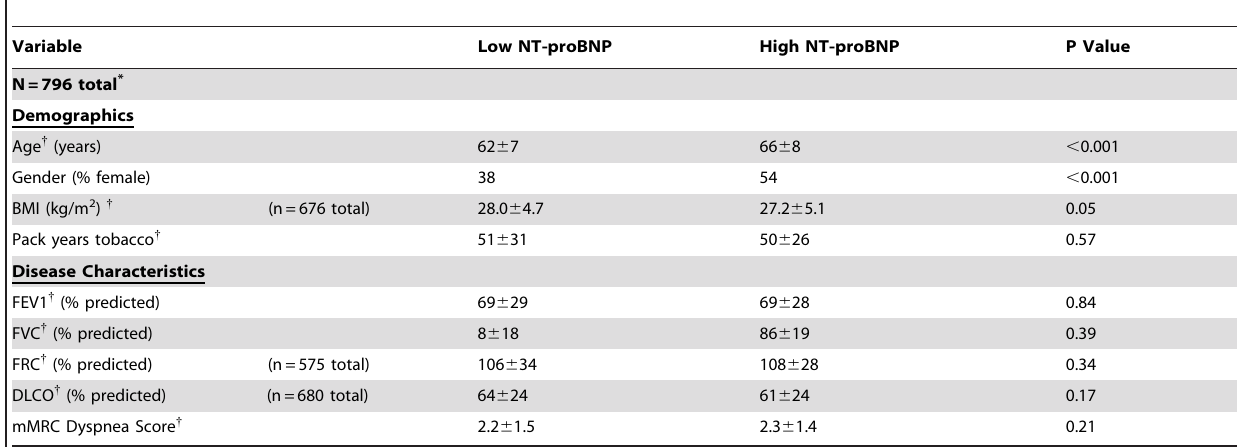
Table 2. Predictors of Elevated N-terminal pro-BNP ( $ 49 pg/mL).